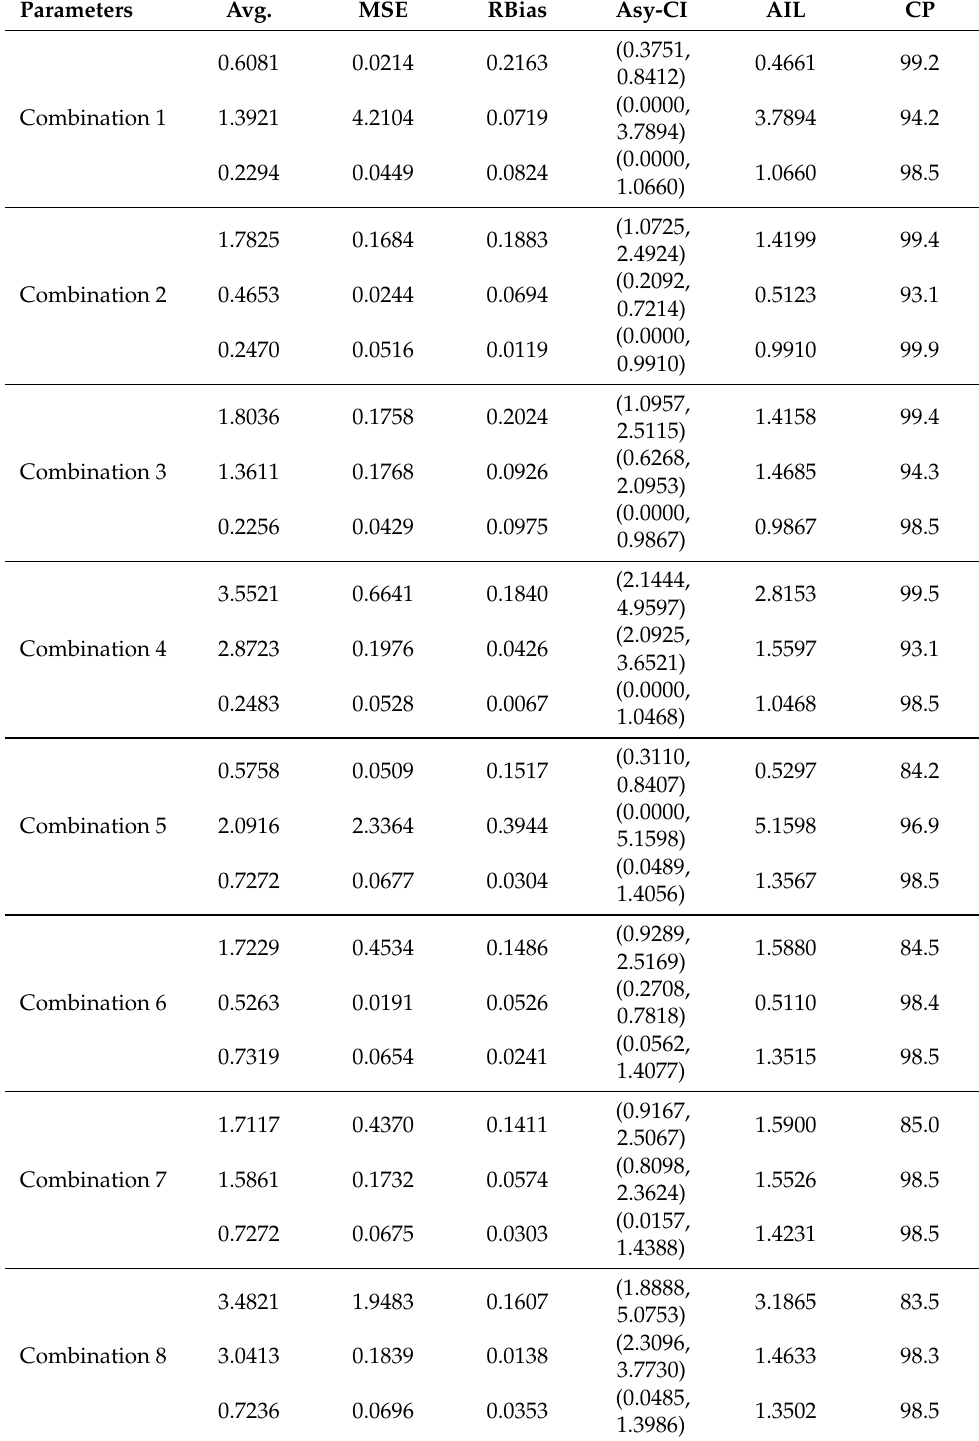
Table 9. Average estimated values, MSEs, CIs, AILs and CPs (in %) of the MLE for the FB distribution at N = 50 and n =